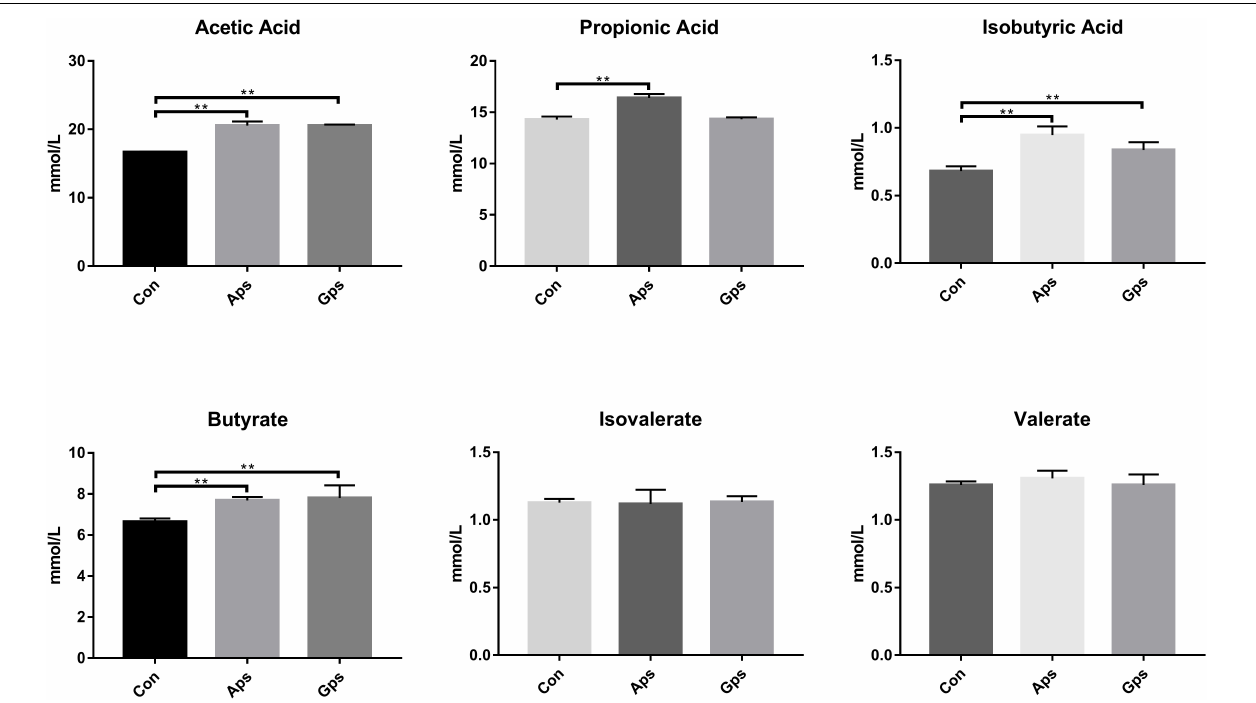
FIGURE 5 | Effect of the Aps and Gps on the VFAs in colon content of weaned piglets. Con represents the control piglets; Aps represents the piglets supplemented with the astragalus polysaccharide; Gps represents the piglets supplemented with ginseng polysaccharide. ∗∗ Means significant difference ( P < 0.01). Values means n = 6 for the analysis of